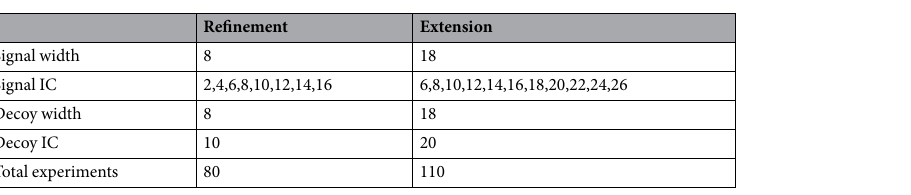
Table 4. Parameters of implanted signal and decoy